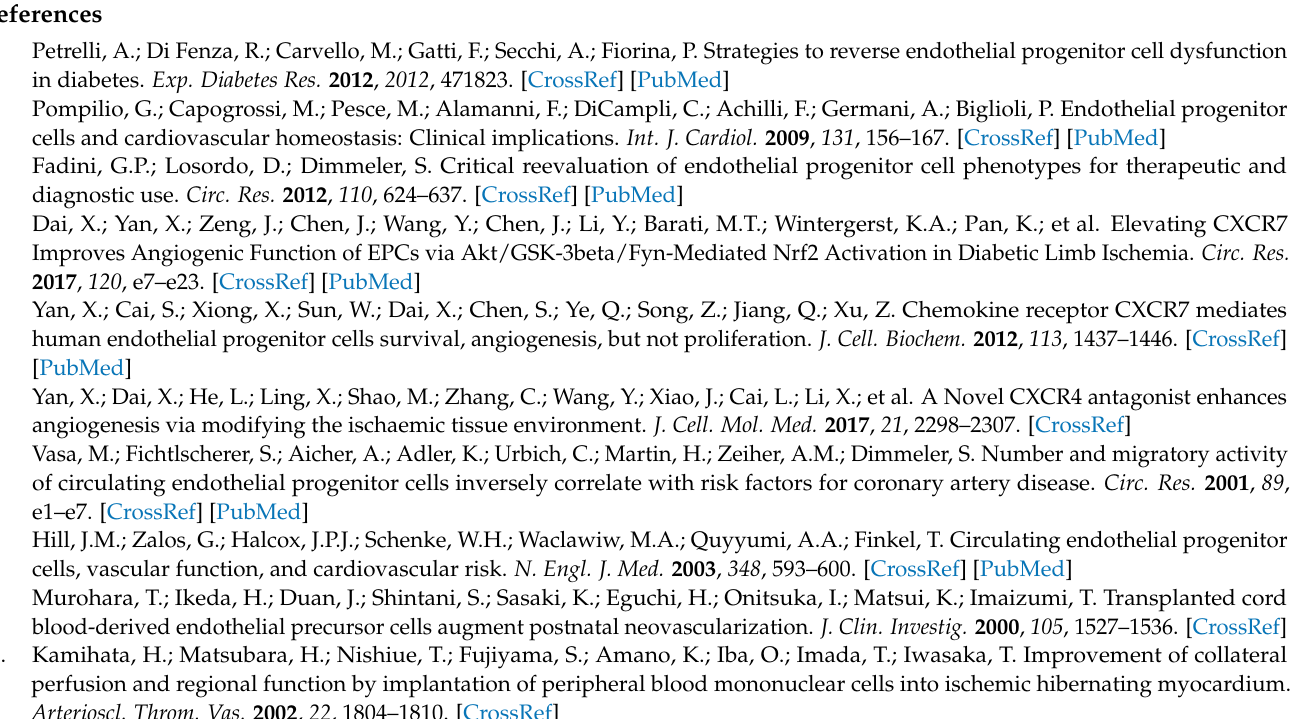
Figure S6: Exendin eliminated the effects of liraglutide on AKT pathway activation in HG-treated EPC; Figure S7: Wortmannin abrogated the effect of liraglutide in restoring NO bioavailability in HG-treated